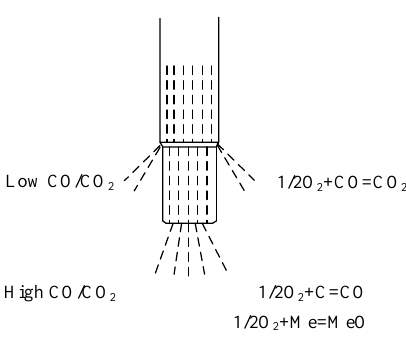
Figure 4. Schematic diagram of a secondary combustion oxygen lance.